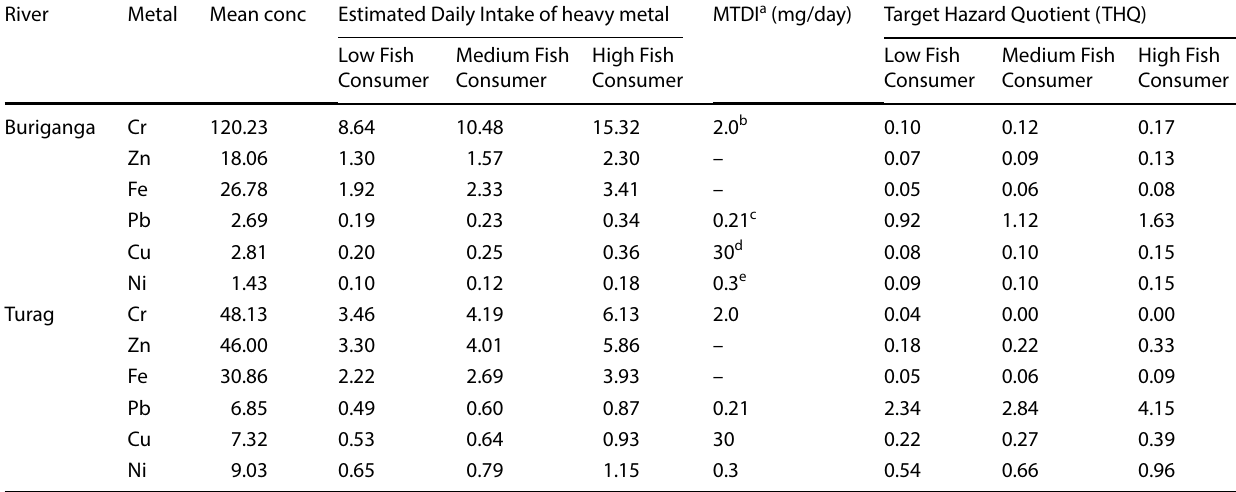
a MTDI: maximum tolerable daily dietary